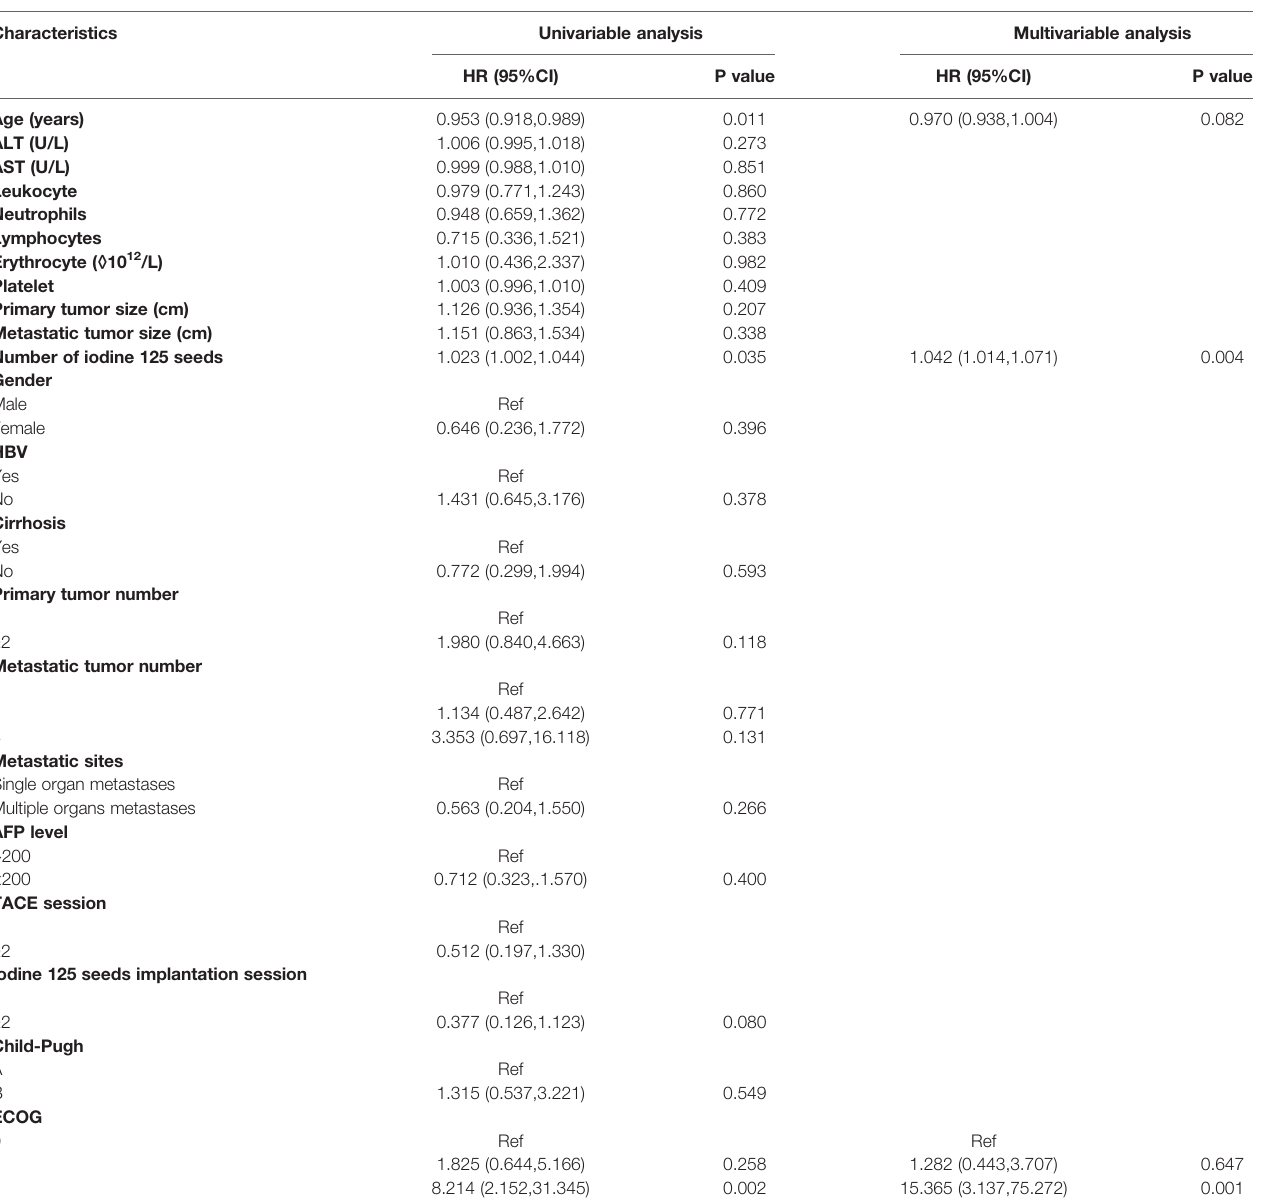
TABLE 5 | Univariable regression analysis and multivariable regression analysis for PFS of metastatic sites.